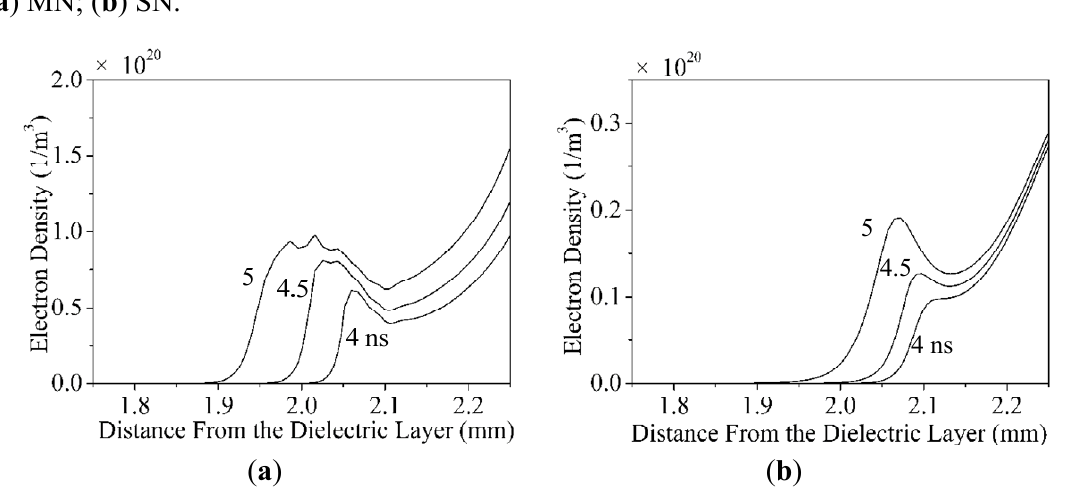
Figure 15. Electron density distribution (1/m 3 ) along the axis of symmetry of the TNG: ( a ) MN; ( b )